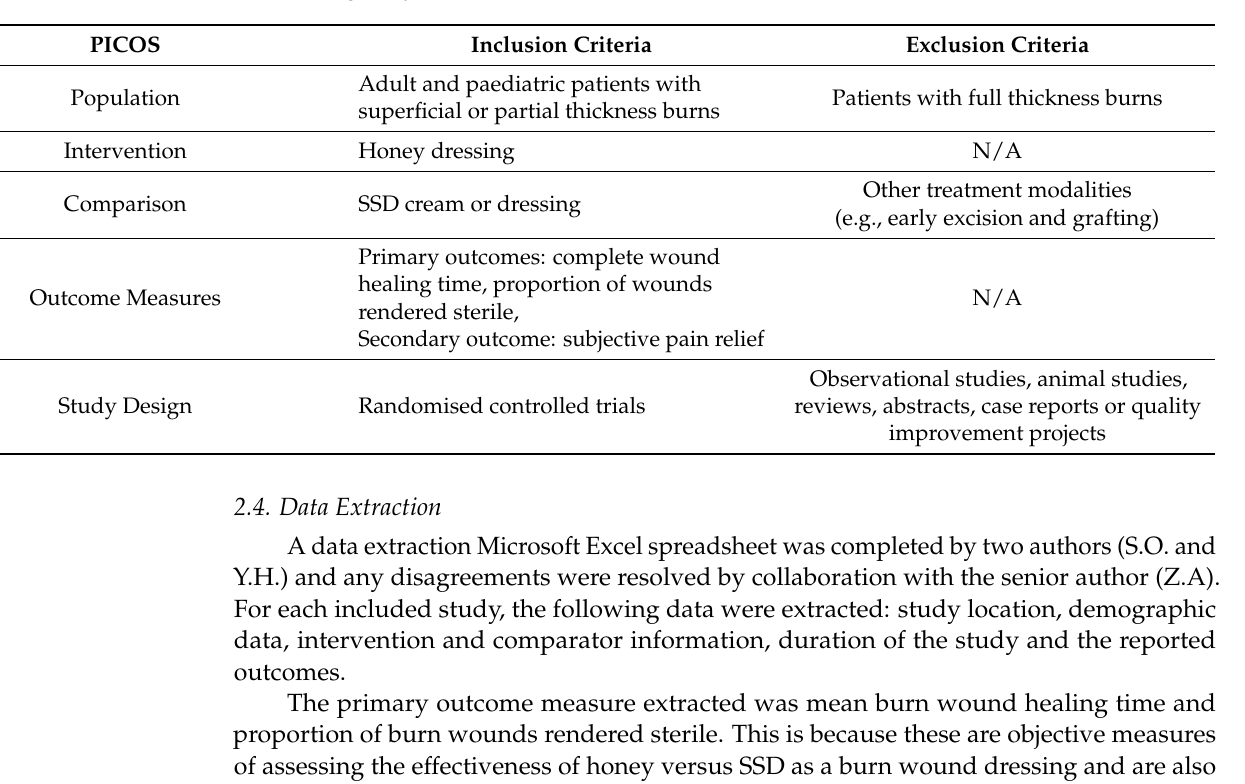
Table 1. Eligibility